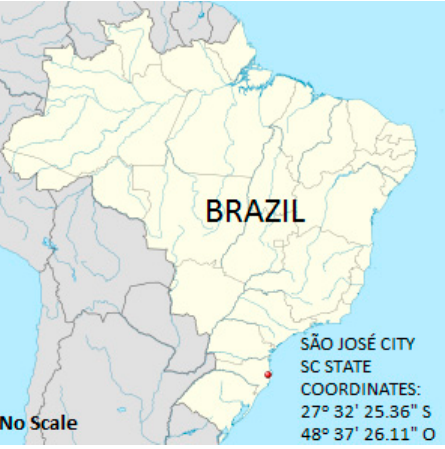
Figure 1. Location of site for installation of filters for rainwater treatment.